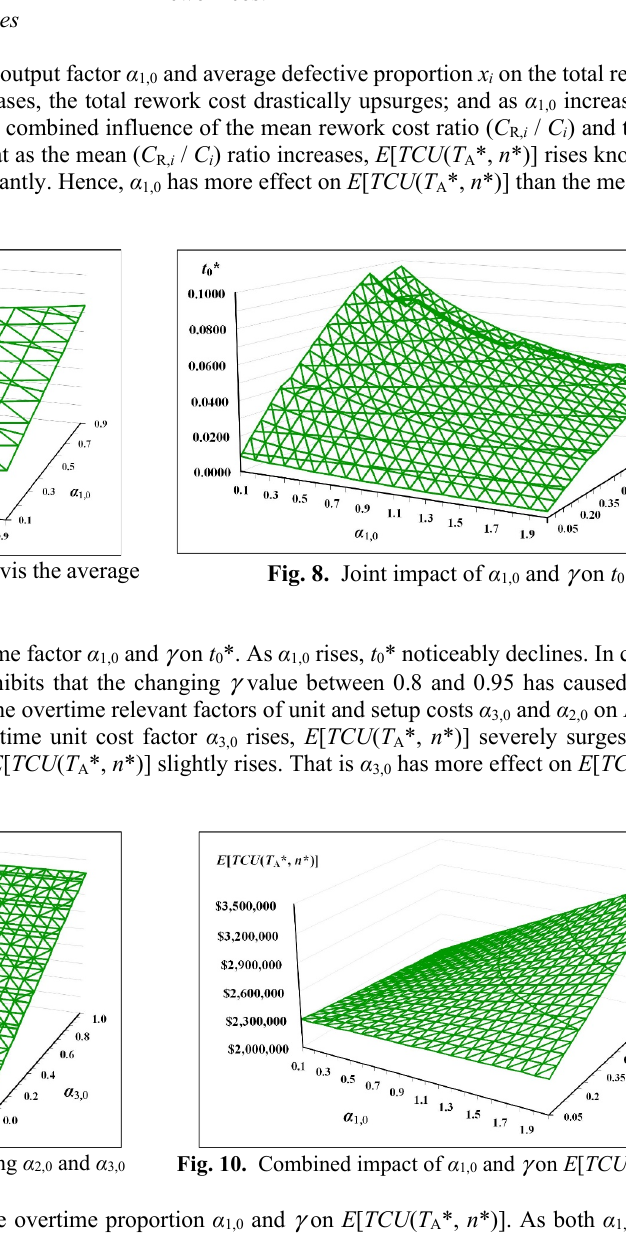
Fig. 5. The behavior of E [ TCU ( T A , n )] regarding to T A and n Fig. 6. Combined effect of α 1,0 and the mean x i on the total rework cost